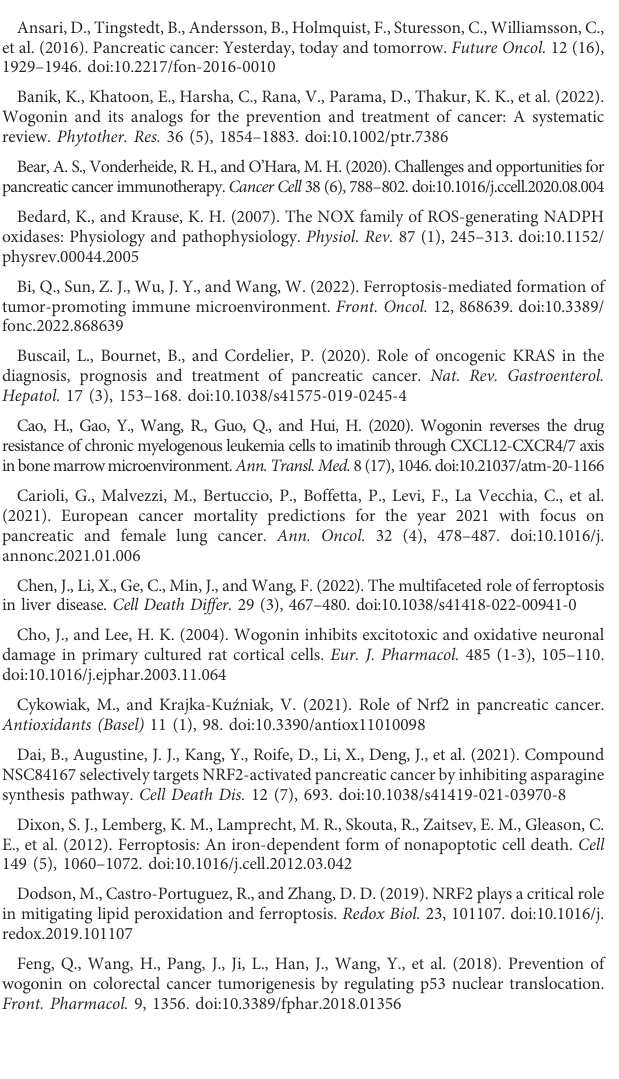
SUPPLEMENTARY FIGURE S1 Knockdown of Nrf2 contributed to wogonin-induced ferroptosis in pancreatic cancer cells. (A) RT-qPCR analysis was performed to detect NFE2L2 mRNA expression in PAAD cells transfected with or without si- NFE2L2 . (B) Wogonin-induced accumulation of lipid peroxidation was prevented when Nrf2 was knockdown. (C) Knockdown of Nrf2 prevented wogonin-induced overproduction of Fe 2+ . (D) Wogonin-induced repression of GSH was improved when Nrf2 was knockdown. *: p < 0.05 versus control group; ****: p < 0.0001 versus the group treated with wogonin alone. SUPPLEMENTARY FIGURE S2 H&E staining for orthotopic xenograft tumor sections (×